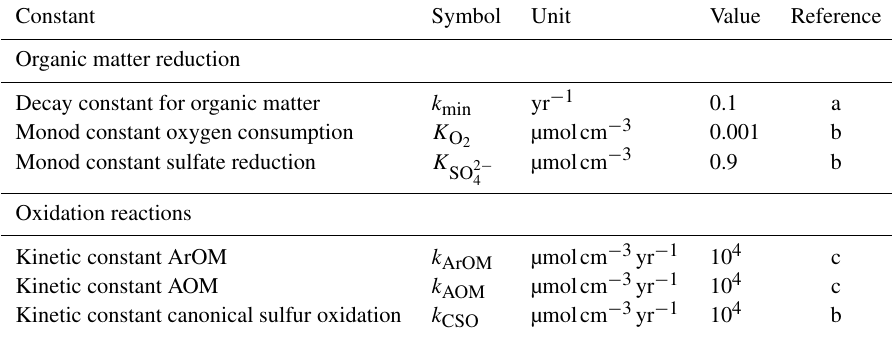
µmolcm − 3 0.001 b 2 µmolcm − 3 0.9 b SO 2 − 4